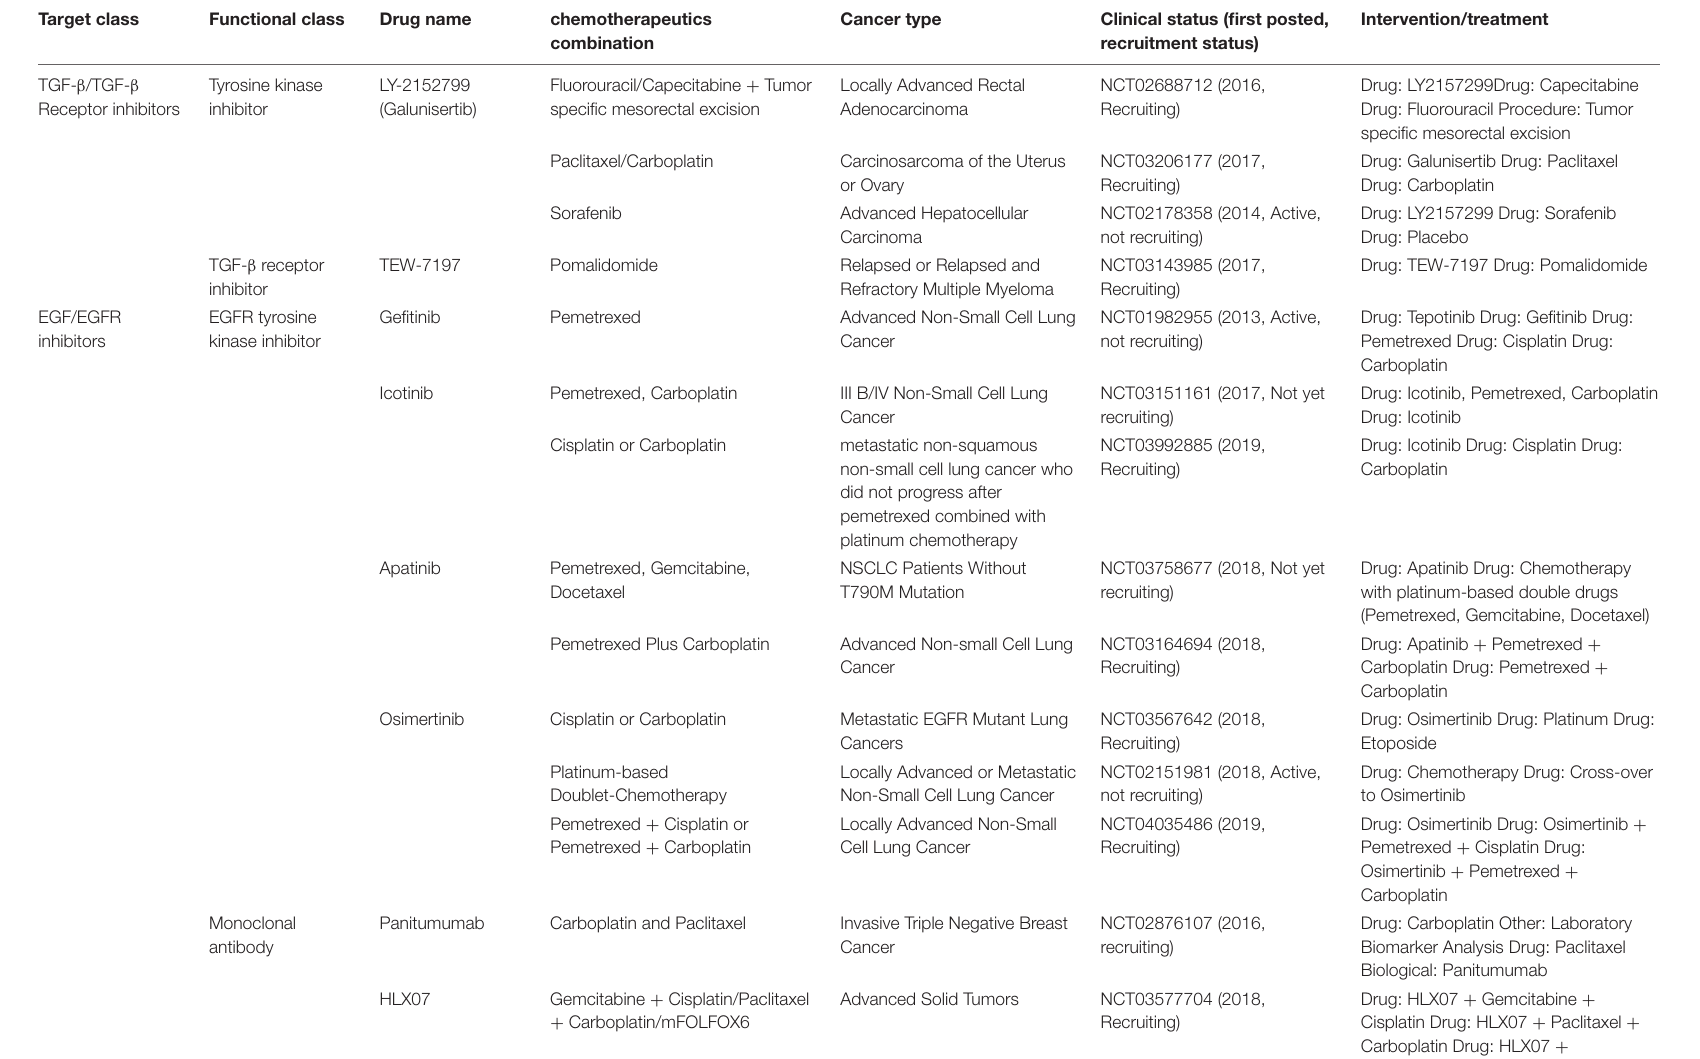
TABLE 1 | List of the current active clinical trials targeting EGF and TGF- β signaling pathways in combination with